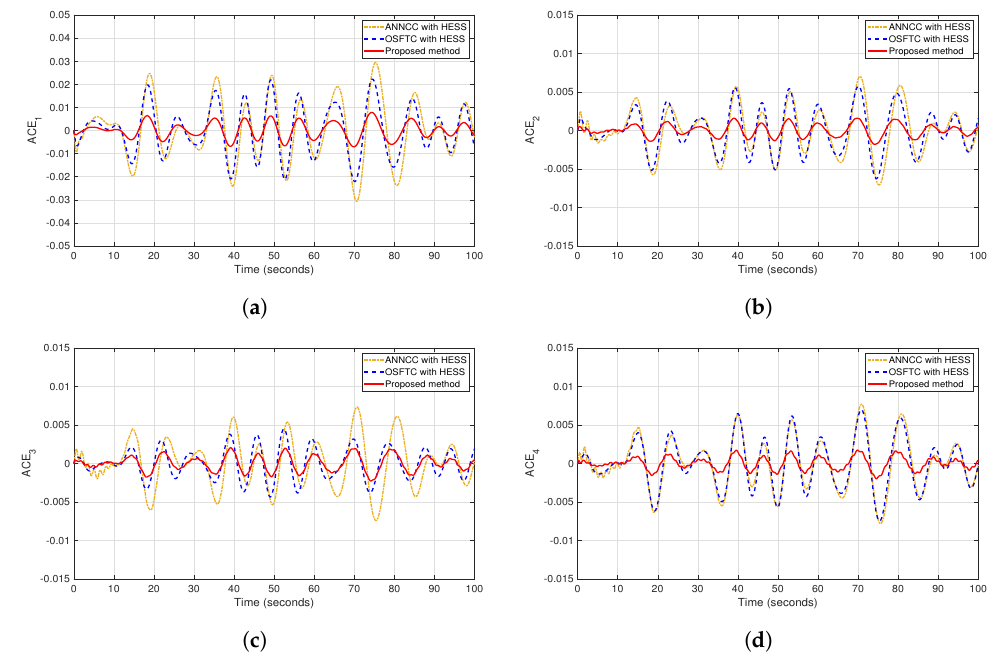
Figure 9. The ACE i of each area subjected to the fluctuated renewable power fluction shown in [36]: ( a ) ACE 1 ; ( b ) ACE 2 ; ( c ) ACE 3 ; and ( d ) ACE 4